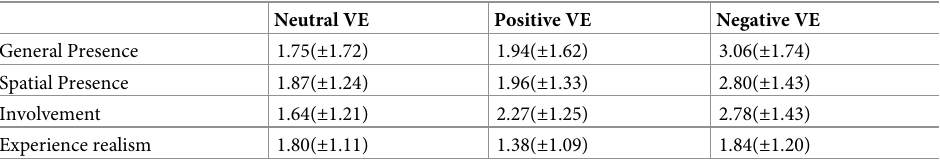
Table 3. IGroup presence scores ( ± SD) for each subscale and VE